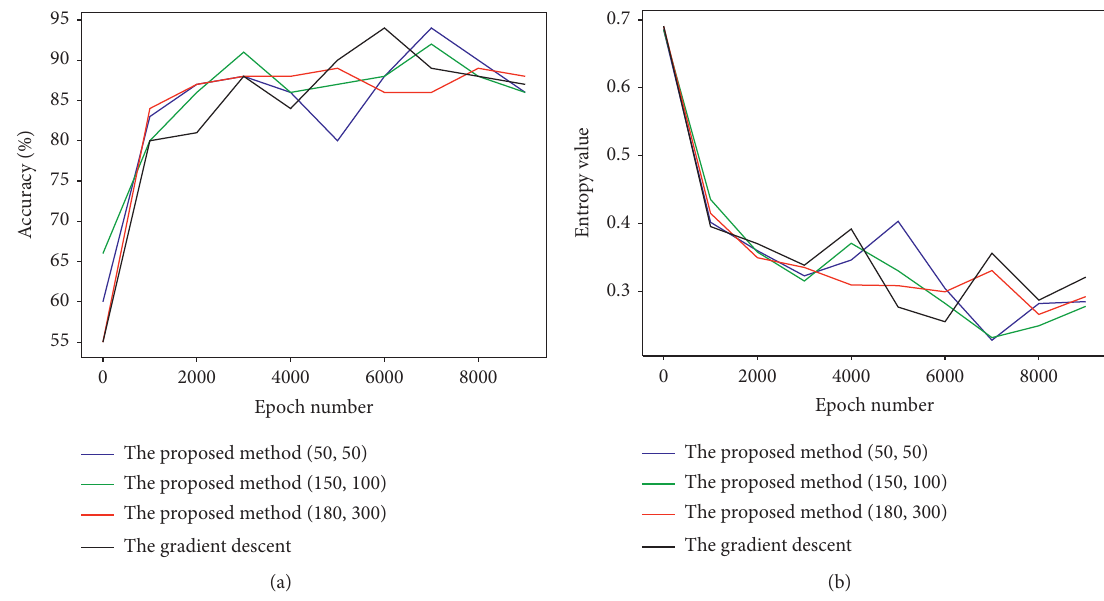
Figure 5: Image classification performance: (a) accuracy after each learning step; (b) cross entropy after each learning